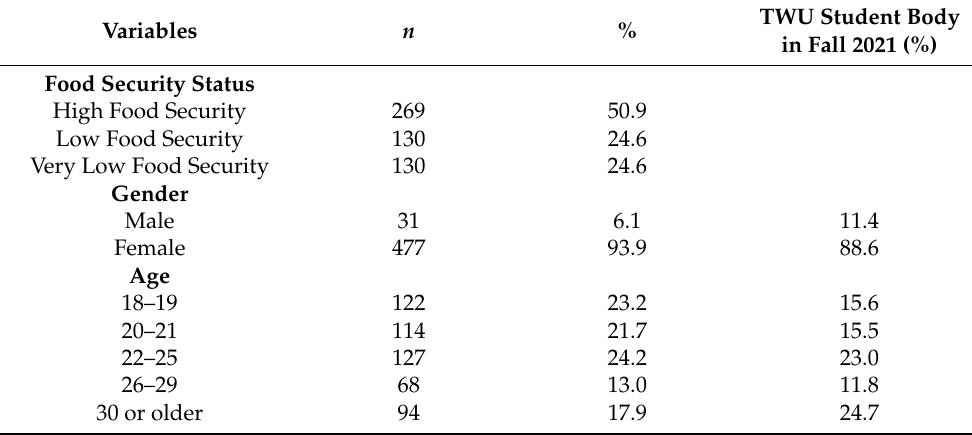
Table 1. Food Security Status and Demographic Characteristics of Survey Participants versus TWU Denton Students Body’s